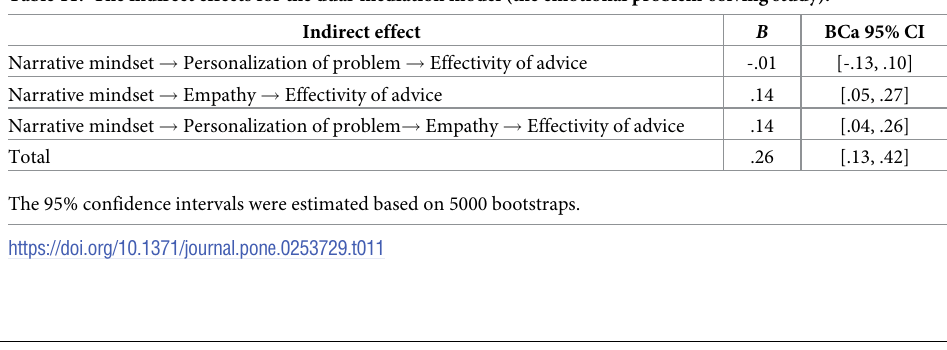
Table 11. The indirect effects for the dual-mediation model (the emotional problem-solving